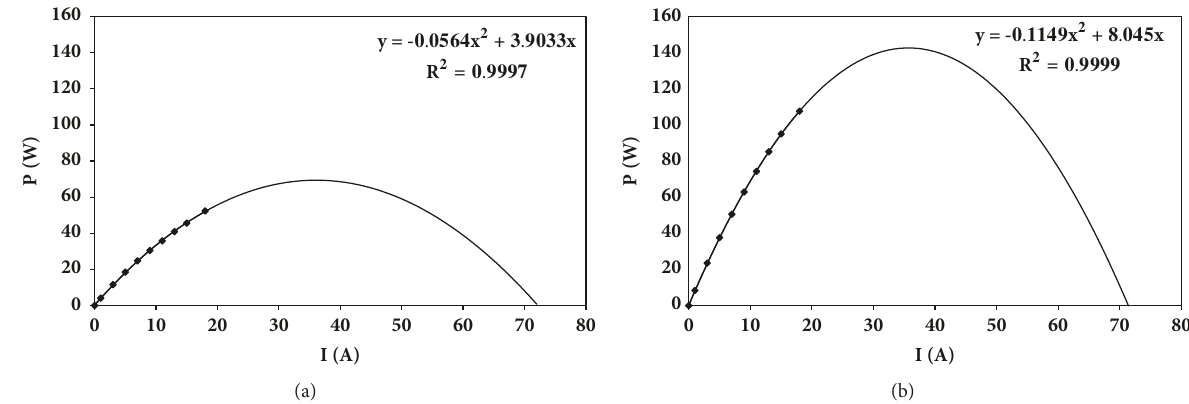
Figure 3: Graphical representation of power as a function of current intensity of fuel cell with an active area of 100 cm 2 : (a) of 5 and (b) of 10 unit cells.